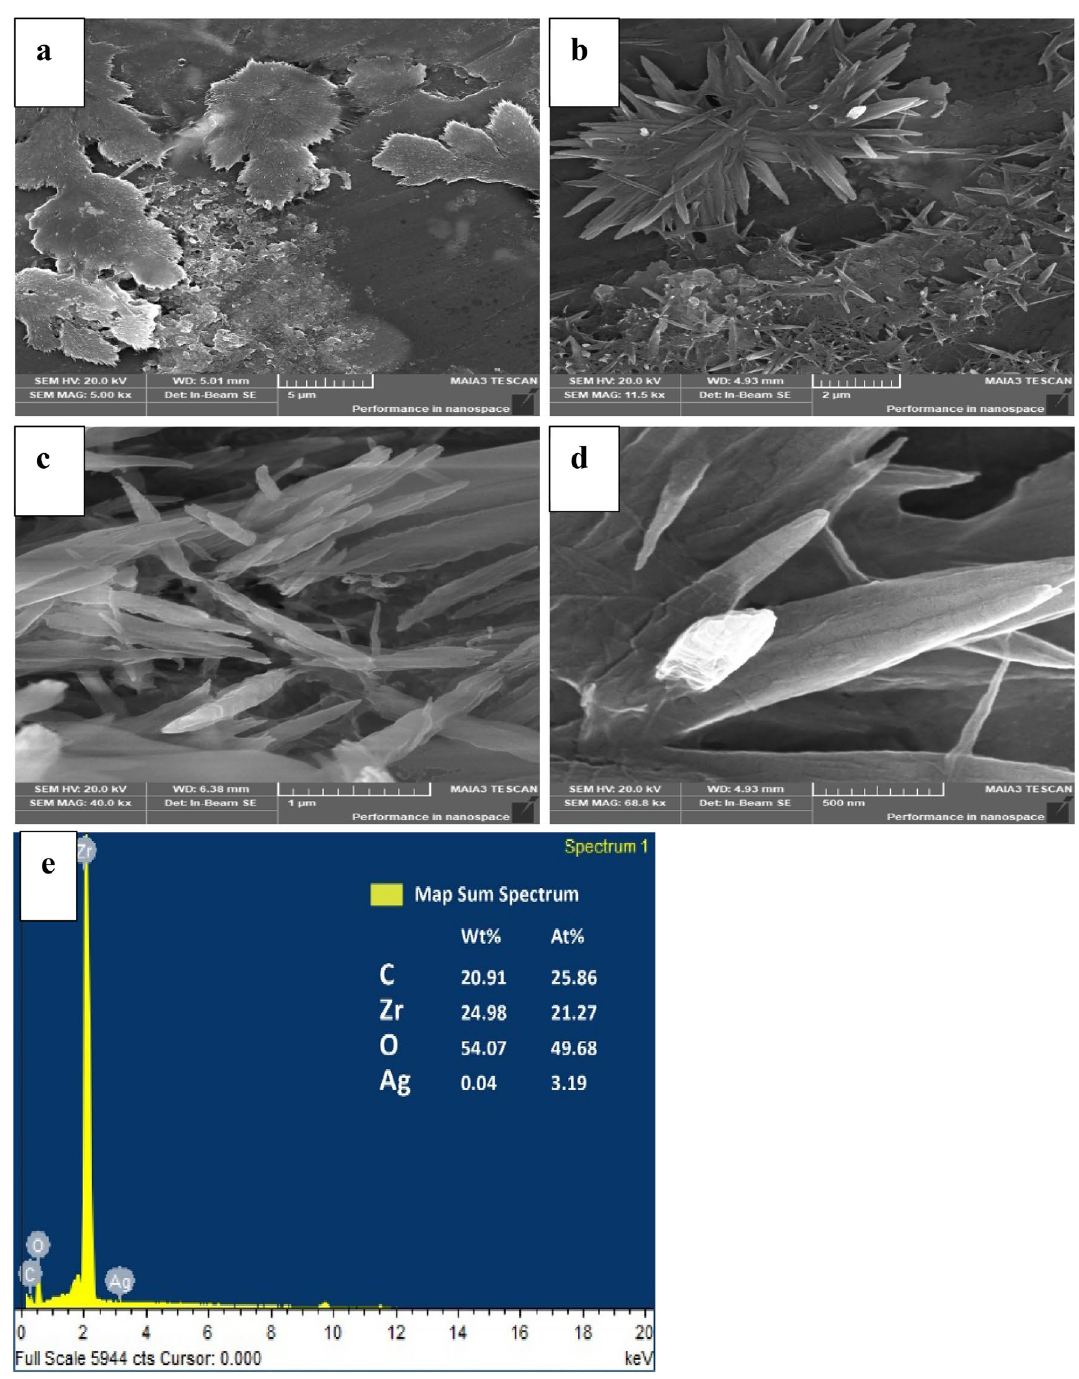
Figure 2. ( a – d ) Scanning electron micrographs of Ag 0.04 ZrO 2 /rGO and (e) EDX of Ag 0.04 ZrO 2